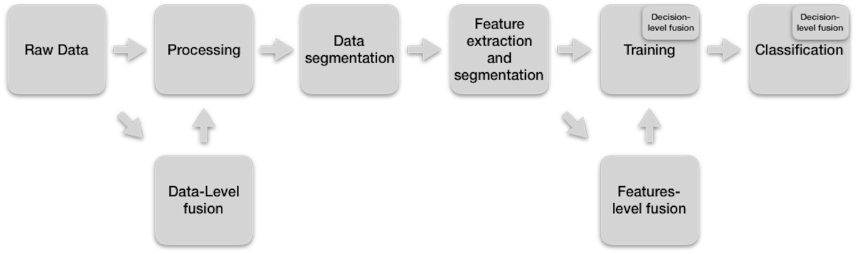
Figure 2. Extended activity recognition